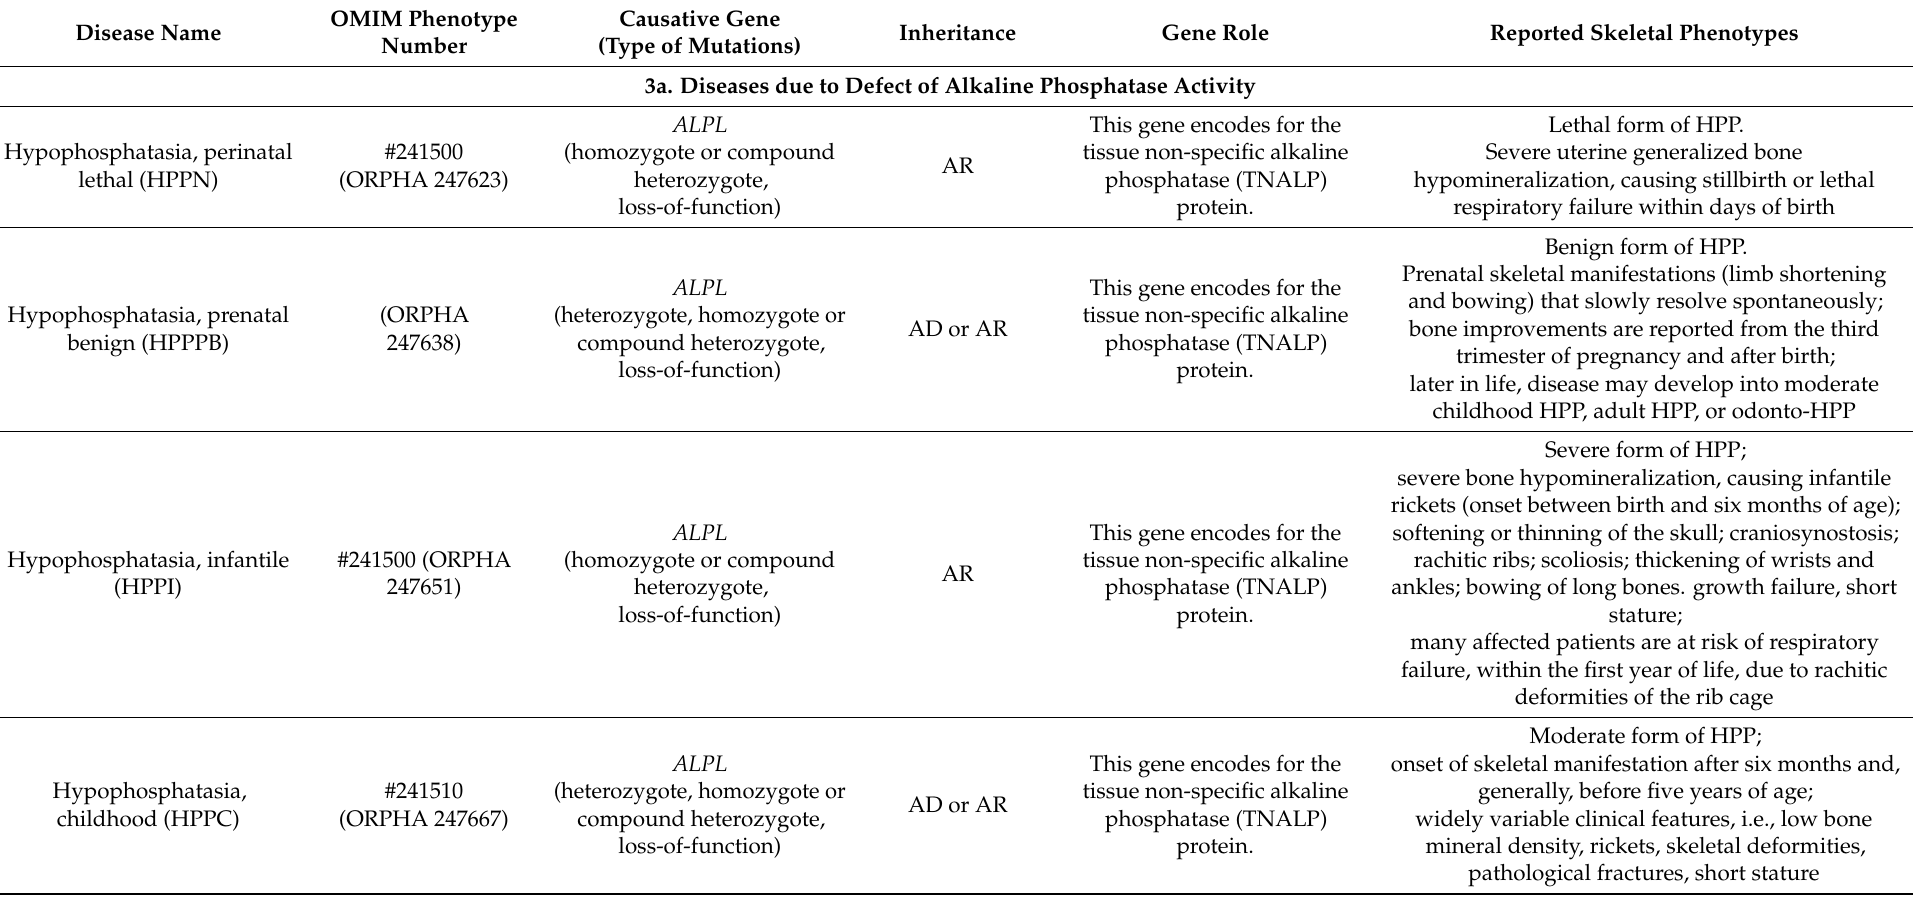
Table 3. Congenital metabolic bone disorders due altered bone microenvironmental